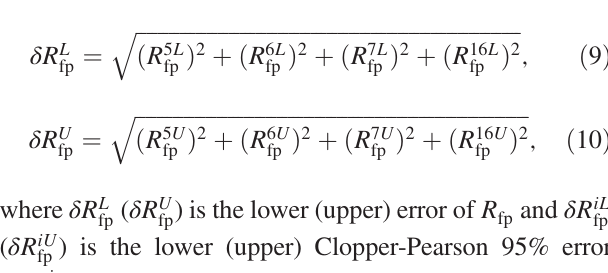
FIG. 4. P i (vertical axis, white circle) and P i raw given S (horizontal axis). The error bars ( P i raw intervals of the dependent